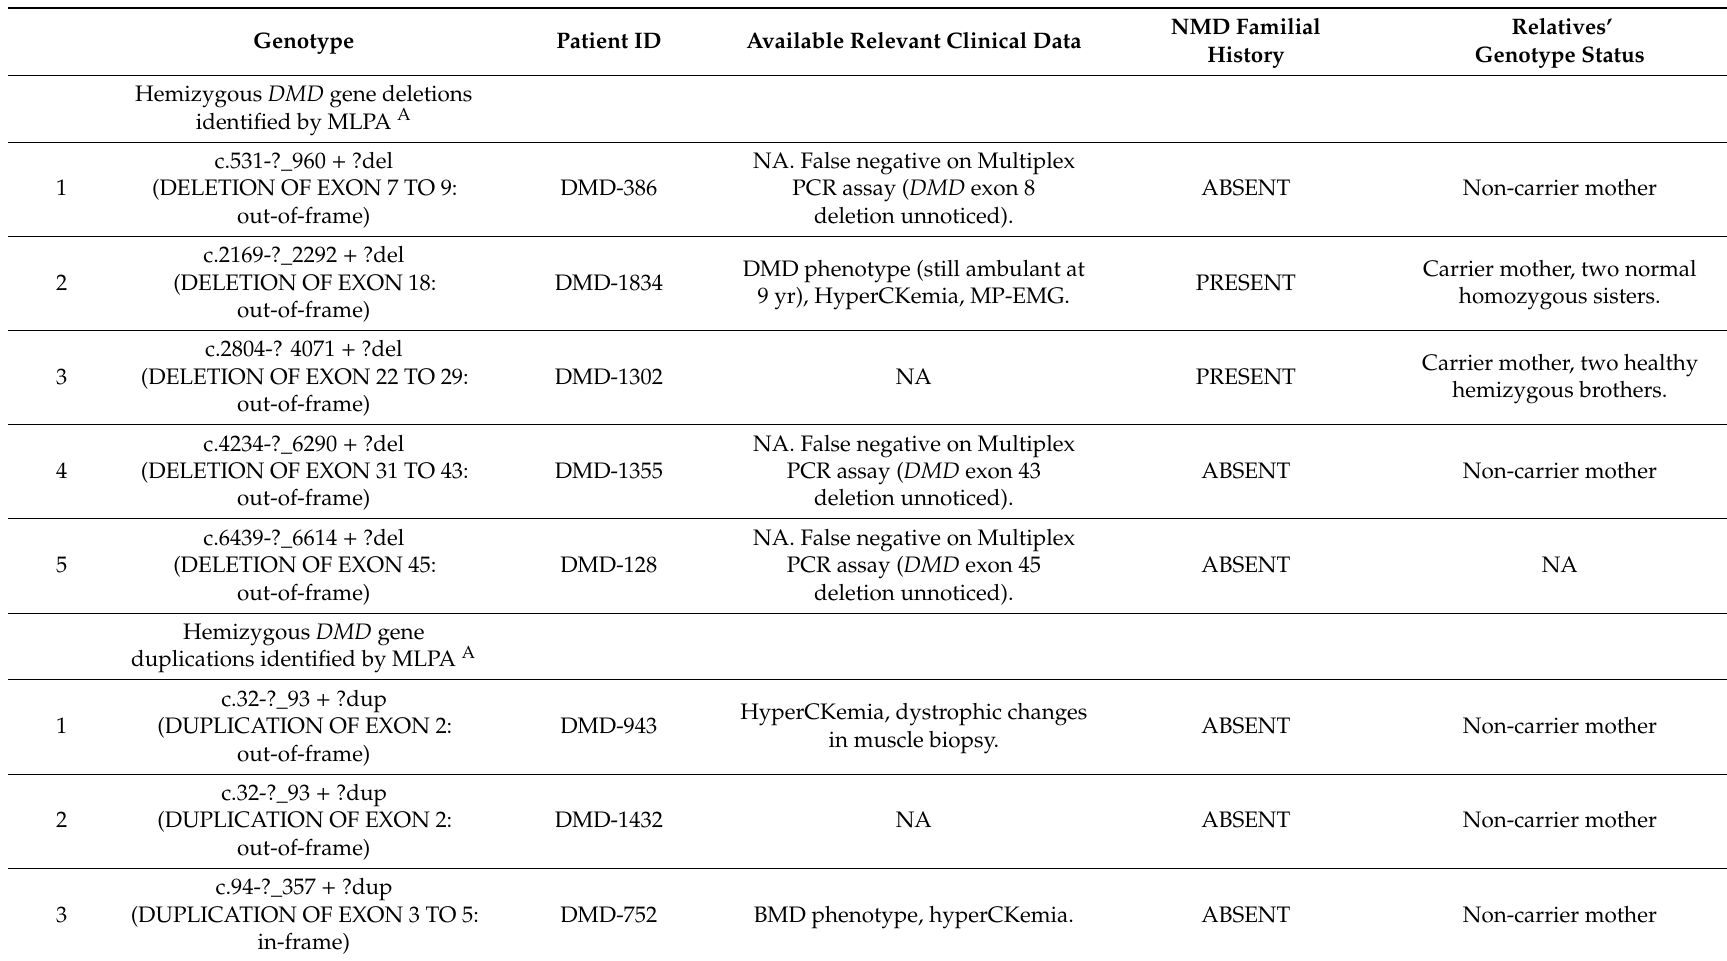
Table 1. Genotypic and genealogical data from Mexican male patients with a suspicion of muscular dystrophy and normal multiplex PCR results for 22 DMD gene exons and further confirmed genetic diagnosis for dystrophinopathy or